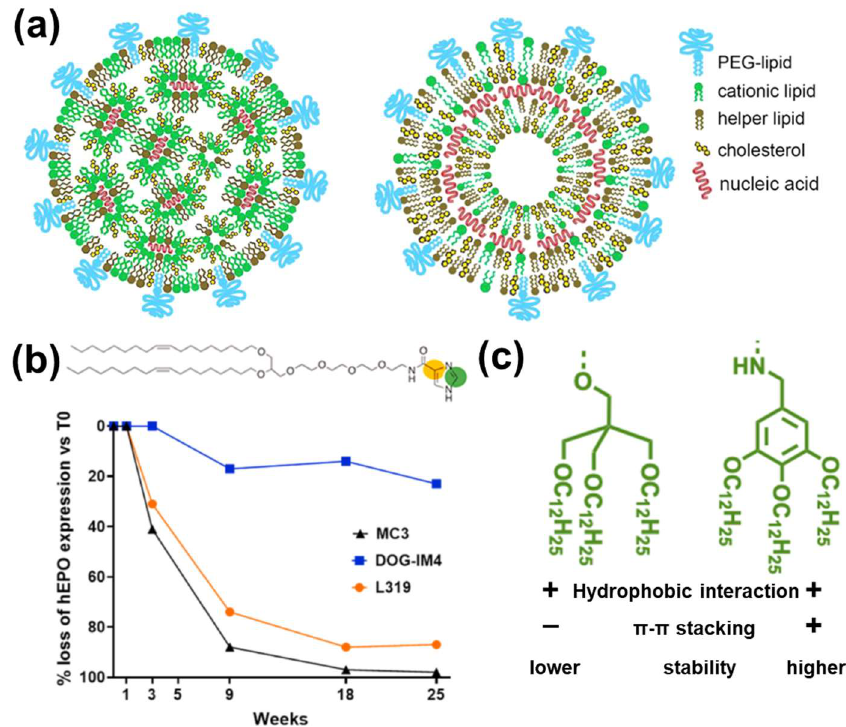
Figure 4. ( a ) Two suggested structures of mRNA-encapsulated LNPs, reproduced with permission [81]; ( b ) the loss of expression of mRNA encapsulated in LNPs containing imidazole (DOG-IM4), and tertiary amines (MC3 and L319) as ionizable lipids, reproduced with permission [75]; ( c ) a structural comparison between ionizable lipids with and without aromatic groups in the lipid tail, reproduced with permission [83].